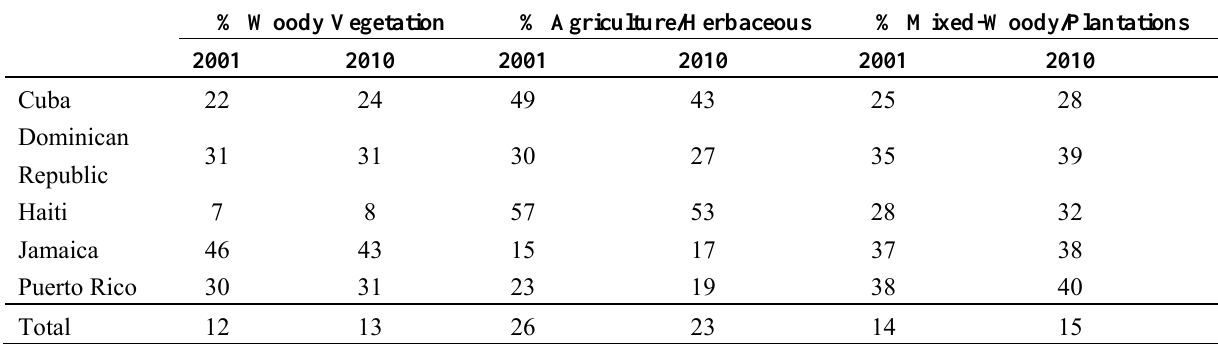
Table 4. Percentage of the countries (% land) in the different land classes in 2001 and 2010. These percentages include all municipalities within a country ( i.e. , non-significant change in addition to significant